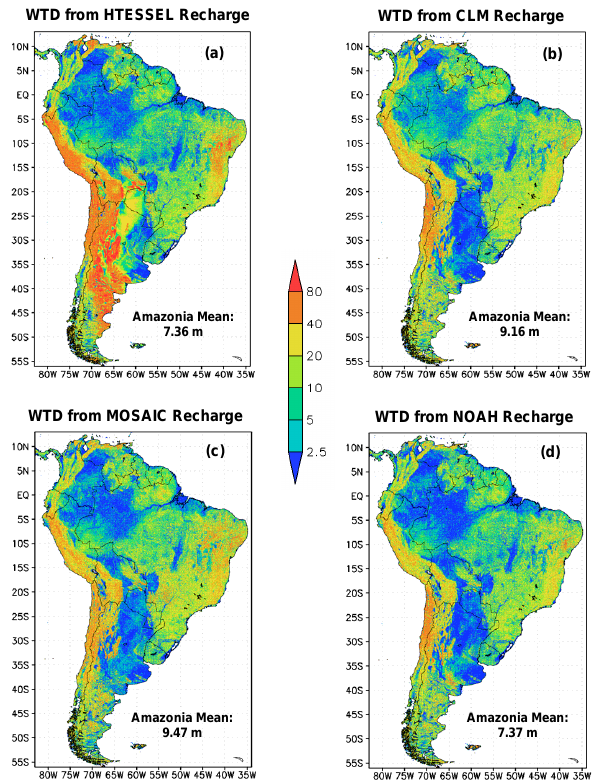
Fig. 5. Simulated equilibrium water table depth (m) forced by recharge from (a) HTESSEL, (b) CLM, (c) MOSAIC, and (d) NOAH.